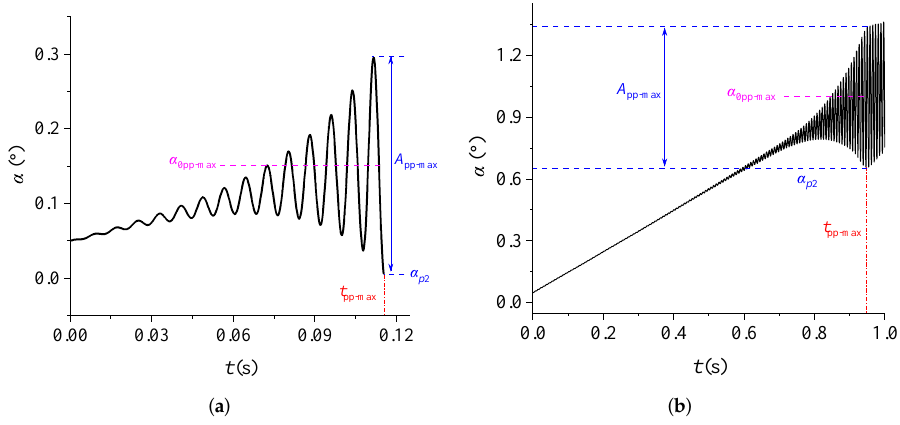
Figure 15. The time histories of the guide vane opening during the pump mode’s starting up process: ( a ) under the condition of c ∗ e = 0.06%; ( b ) under the condition of c ∗ e = 0.39%.